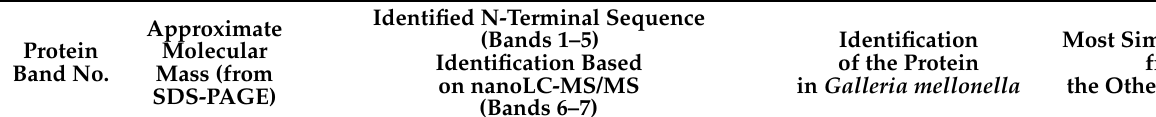
Table 1. Identification of G. mellonella hemolymph proteins binding to A. niger α -1,3-glucan. The number of particular protein band corresponds to number presented in Figure